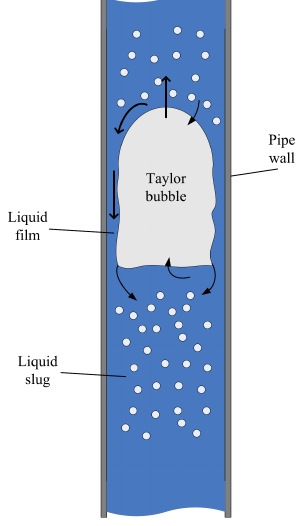
Figure 1. Schematic of a slug flow